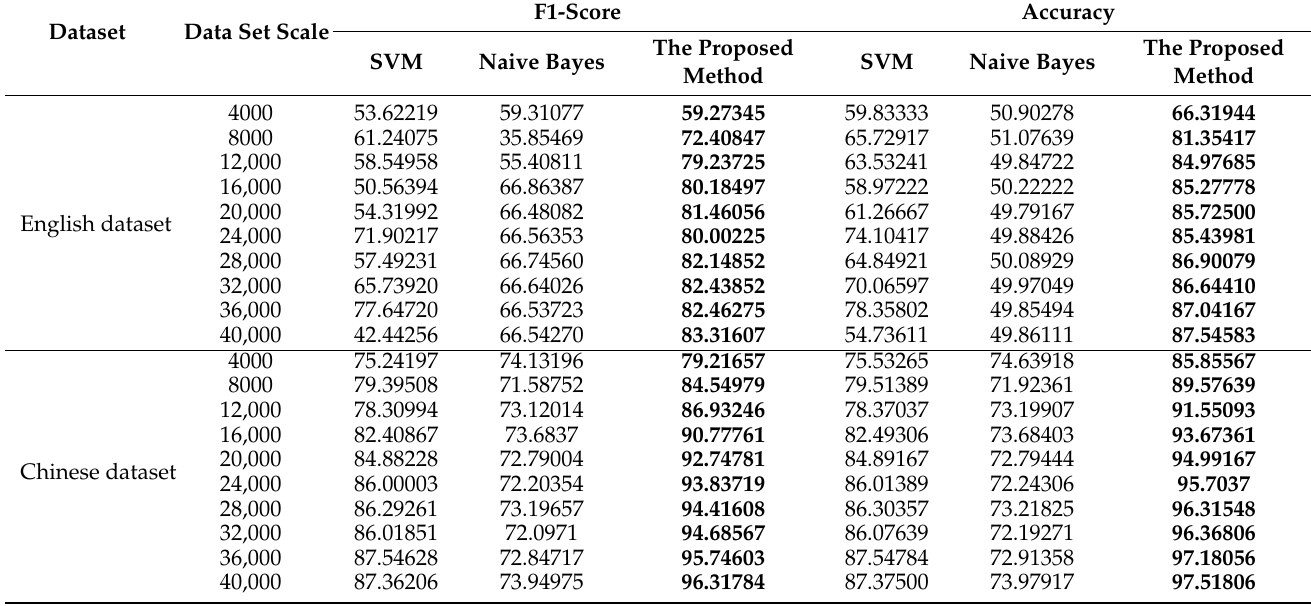
Table 3. The performance of different methods on the Chinese and English